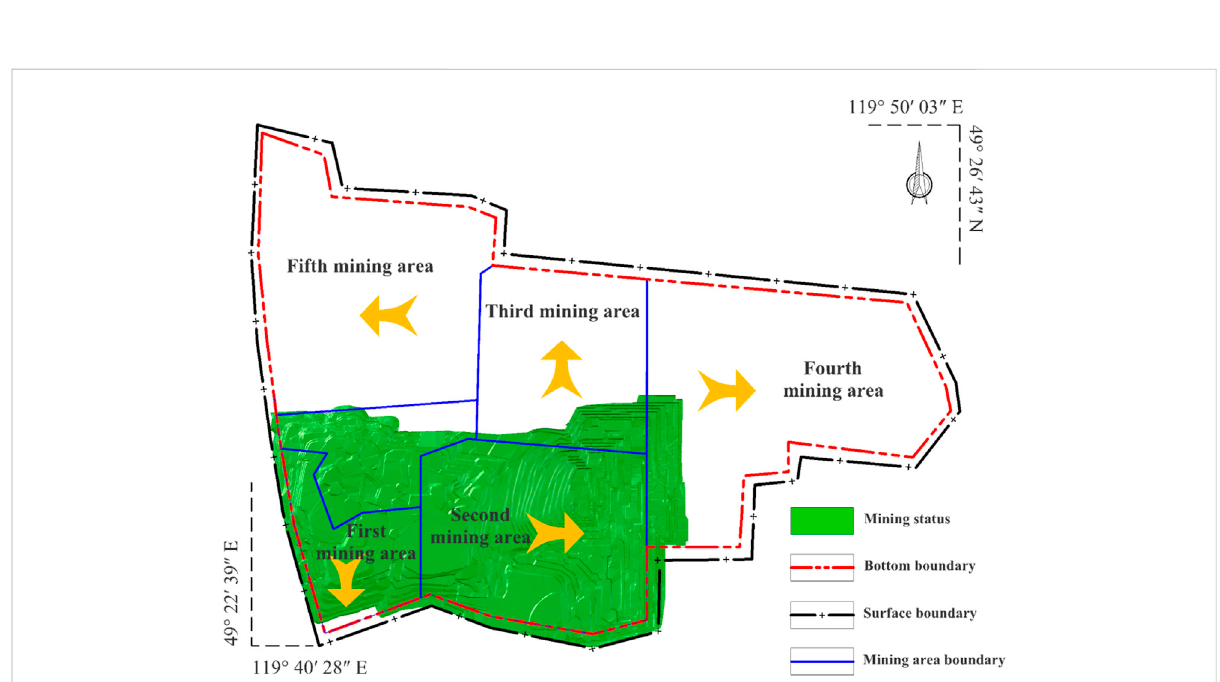
FIGURE 6 The mining area division of the Baorixile open-pit coal mine.